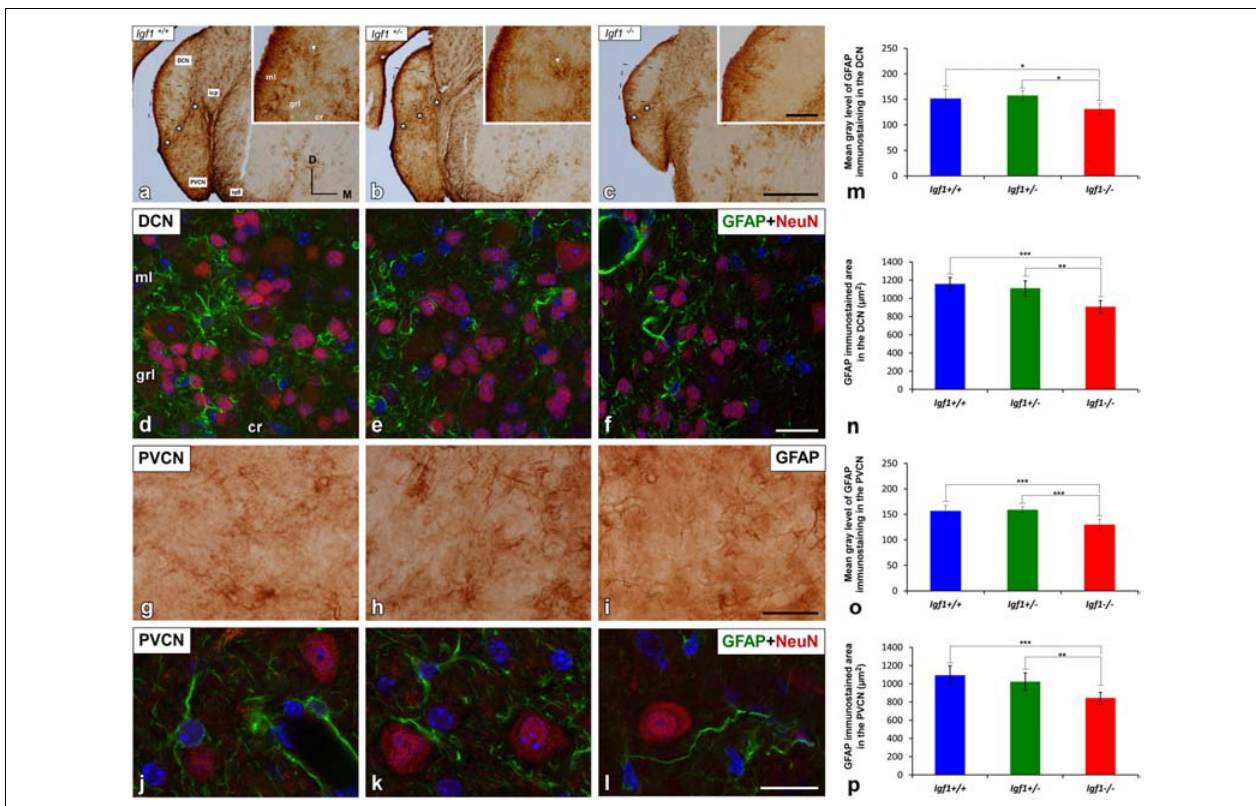
FIGURE 5 | GFAP immunostaining in the DCN and PVCN of Igf1 − / − mice. GFAP immunostaining was distributed throughout the different DCN layers in all the genotypes analyzed (A–F) . GFAP-immunostained astrocytes were strongly stained in the molecular layer while only a few astrocytes were observed in the intermediate layer and central region of the DCN (A–C) . Note that some of these astrocytes group together forming patches of immunostaining (arrows in A,B ). In the Igf1 − / − mice, GFAP immunostaining was apparently weaker in the deeper layers (grl and cr) of the DCN and in the PVCN than in Igf1 + / + and Igf1 + / − mice (A–C,G–I) . The spatial relationship between neurons and astrocytes in all genotypes is shown in Z-stack confocal microscopy images of the DCN (D–F) and PVCN (J–L) . Quantification of the mean gray levels (M,O) and stained areas (N,P) in these nuclei corroborated the decreases in the immunostaining. Asterisks in (A–C) indicate GFAP immunostaining in the granule cell domain. Statistically significant differences among the mouse genotypes were evaluated by one-factor ANOVA ( ∗ p < 0.05, ∗∗ p < 0.01, ∗∗∗ p < 0.001). Cell nuclei in (D–F) and (J–L) are stained with DAPI (blue). The square boxes in (A–C) indicate the location of the higher magnification images shown in (A–C ; insets). Abbreviations: cr, central region of the dorsal cochlear nucleus (DCN); GFAP, glial fibrillary acidic protein; grl, granule/fusiform layer; ml, molecular layer; NeuN, neuronal marker; PVCN, posteroventral cochlear nucleus; sp5, spinal trigeminal nucleus. Scale bars: 500 µ m in ( C ; it also applies to A,B ); 100 µ m in the inset in ( C ; it also applies to insets in A,B ); 20 µ m in ( F,I ; it also applies to D,E,G,H ) and 50 µ m in ( L ; it also applies to J,K